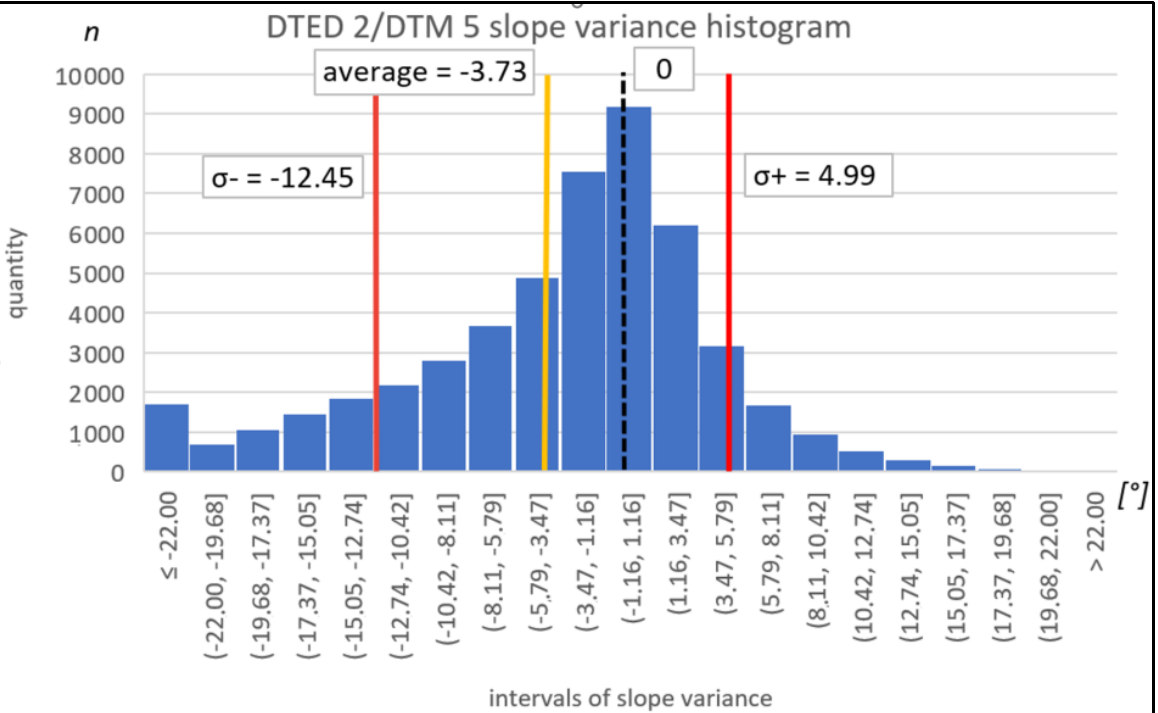
Figure 4. Histogram of standard deviations of comparison between DTED 2 with DTM 5 for slopes at 50,000 points.